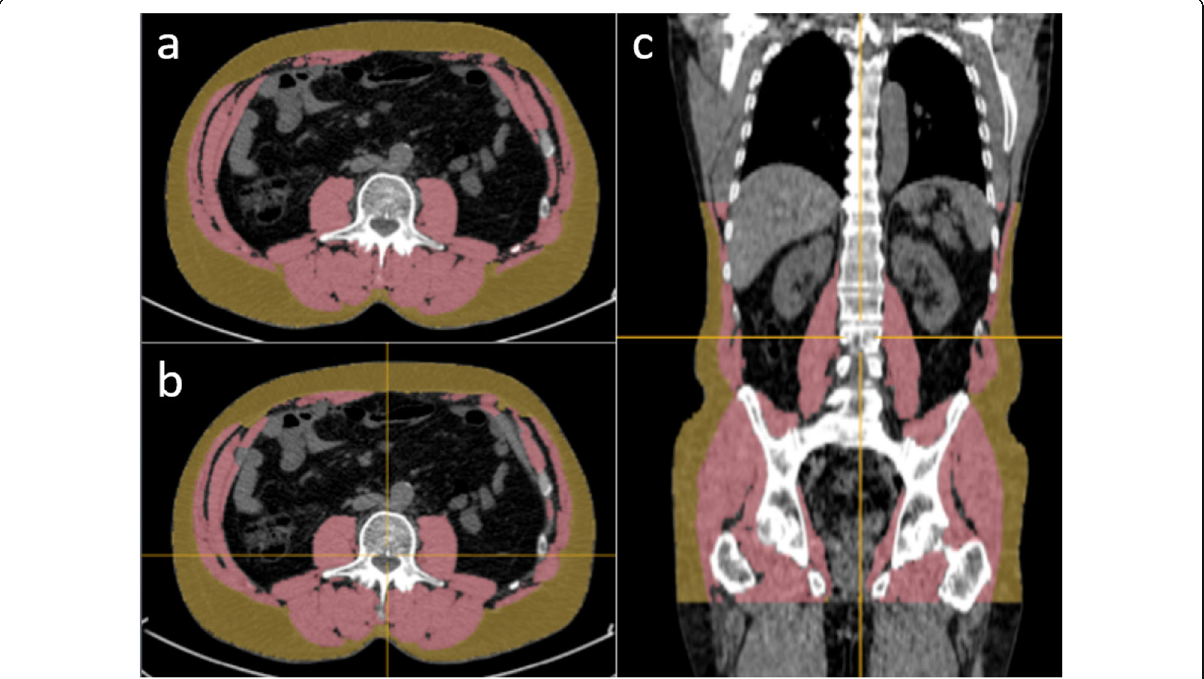
Fig. 1 Manual and AI-based segmentations of SAT and muscle. Left: segmentation on a CT slice at L3 level: manual ( a ) and AI-based ( b ). Coronal slice showing the AI-based 3D segmentation from T11 to the hip bone ( c ). Measurements: manual areas, 186cm 2 (SAT) and 170cm 2 (muscle); AI-based areas, 184cm 2 (SAT) and 158cm 2 (muscle); AI-based volumes 6,832cm 3 (SAT) and 8,253cm 3 (muscle). AI Artificial intelligence, SAT Subcutaneous